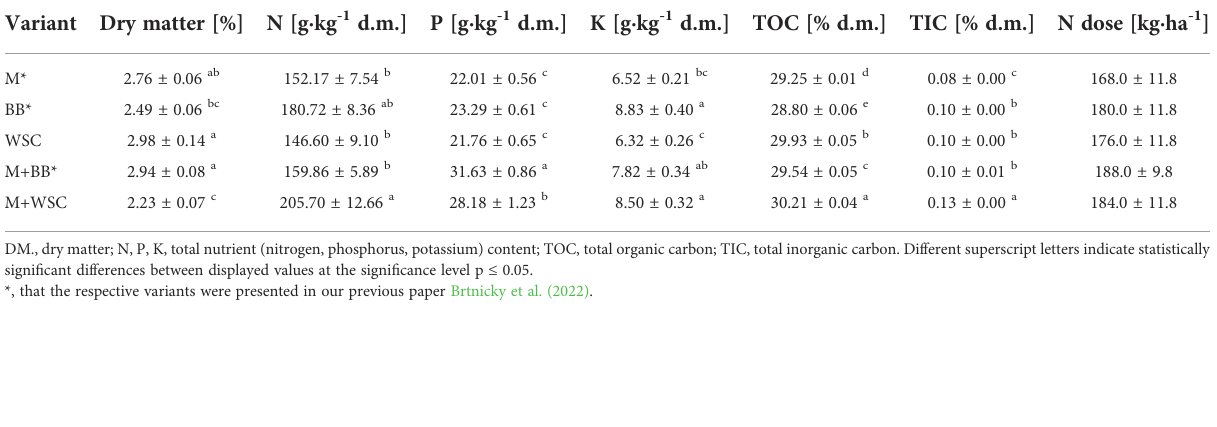
TABLE 2 Properties of digestates, dosage of nitrogen in 40 tons of the digestates per hectare.